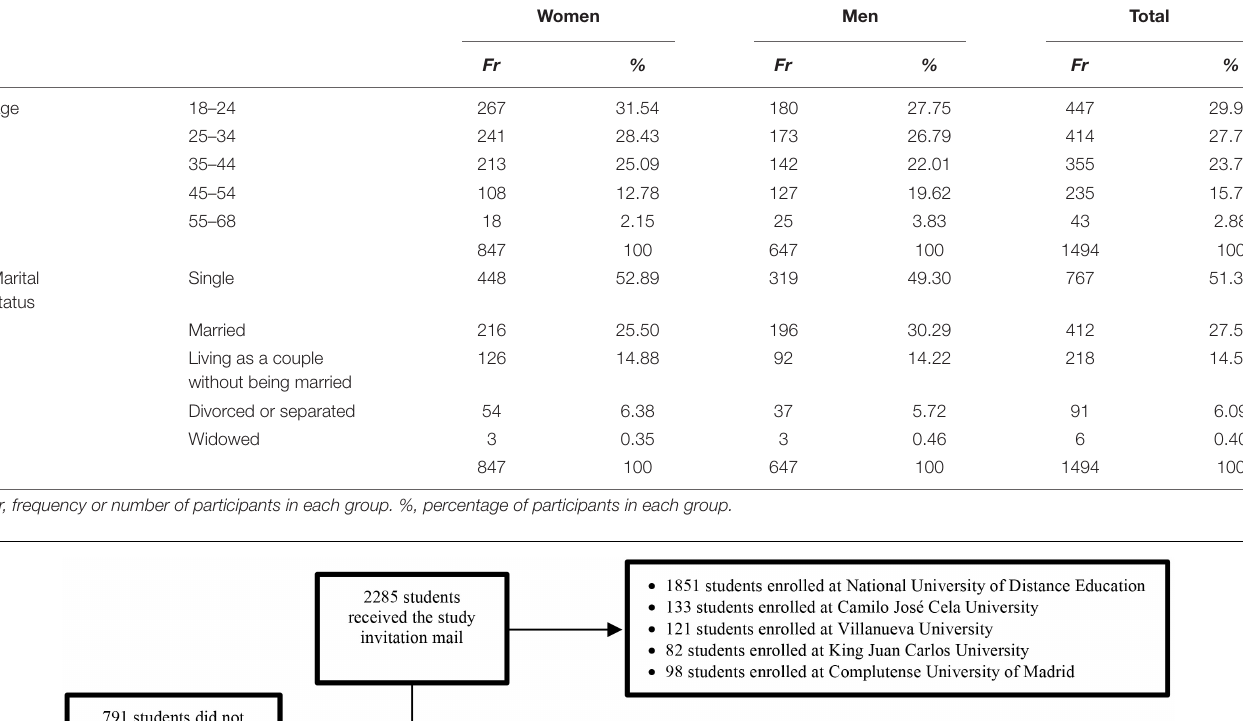
TABLE 1 | Sociodemographic characteristics of the sample.